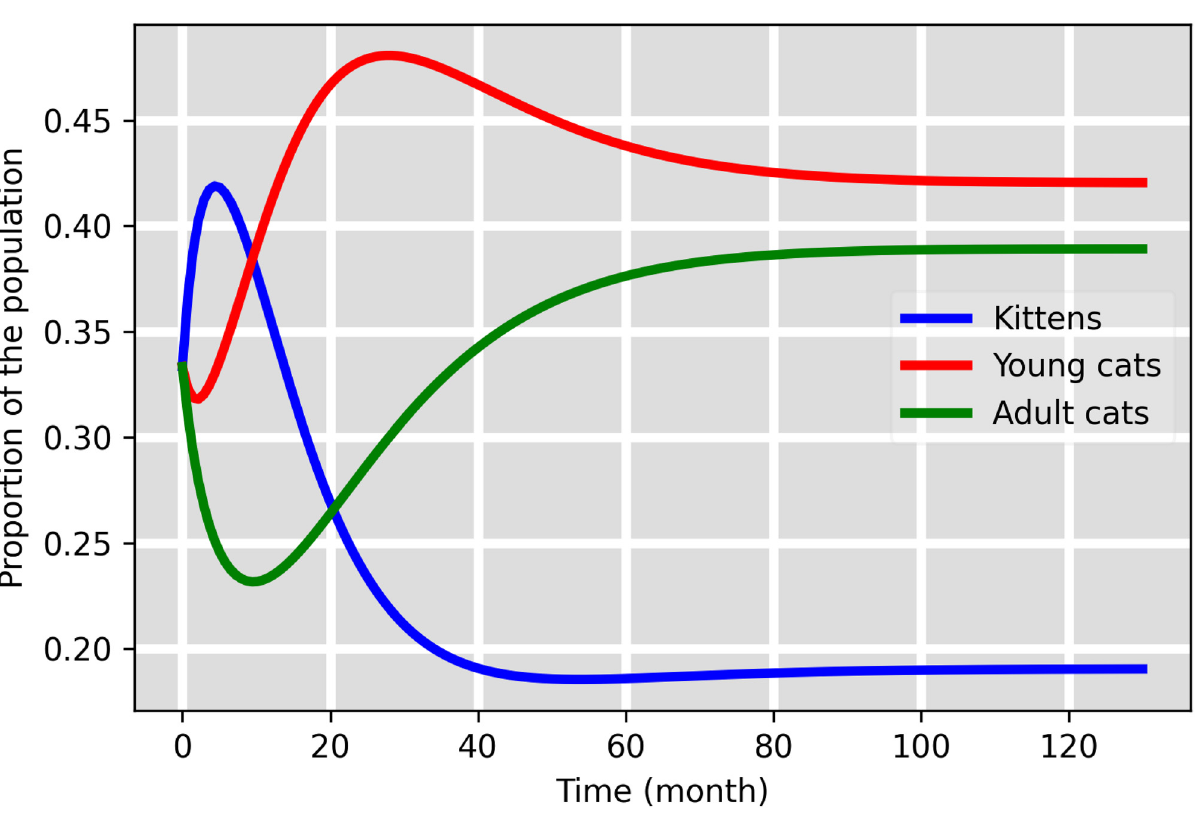
Fig 2. Age distribution of the feline population in the